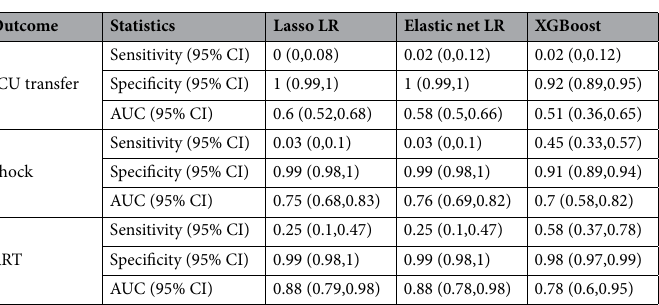
Table 7. Model performance by tenfold cross validation for ICU transfer, shock, and RRT. The sensitivity and specificity were calculated at the cut-off value of 0.5.